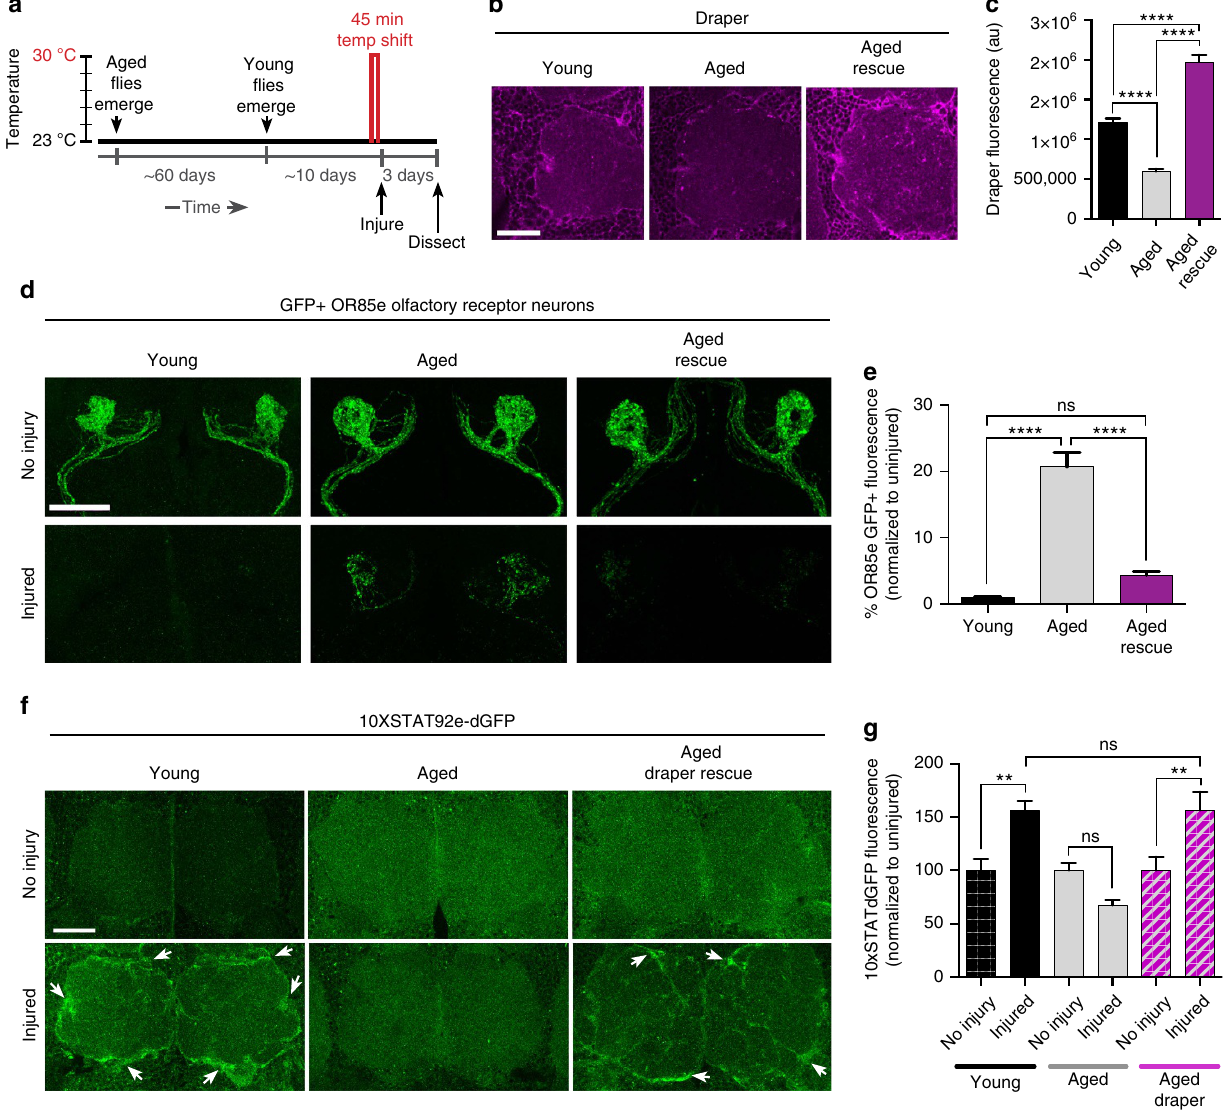
Figure 4 | Expression of Draper in aged glia rescues glial clearance of axonal debris. ( a ) Schematic of the Gal80 ts temperature-regulated paradigm to acutely induce expression of Draper-I in aged glia after injury. ( b ) Representative images of Draper (magenta) immunostained brains. ( c ) Quantification of Draper fluorescence in the cortex of Young, Aged and Aged Draper-I rescue brains; mean ± s.e.m. plotted; **** P o 0.0001, one-way analysis of variance (ANOVA) with Sidak post-hoc test; N Z 20. ( d ) Confocal projections of OR85e GFP þ axonal projections in uninjured flies versus 3 days after maxillary nerve axotomy. Expression of Draper-I in aged glia (Aged rescue) restored normal clearance of axonal debris. ( e ) Quantification of axonal clearance shown in d ; mean ± s.e.m. plotted, NS, not significant, **** P o 0.0001, one-way ANOVA with Sidak post-hoc test. N Z 14. ( f ) Representative images of antennal lobes showing expression of dGFP under the control STAT92E activity ( 10XSTAT92E-dGFP ) immunostaining (green) in Young, Aged and Aged Draper-I rescue animals. ( g ) Quantification of dGFP shown in f ; mean ± s.e.m. plotted, NS, not significant, ** P o 0.01, one-way ANOVA with Sidak post-hoc test; N Z 18. NS, not significant. Scale bars, 30 m m. Genotypes: b – e , Young ¼ w 1118 ;OR85e-mCD8::GFP, tubulin-Gal80 ts / þ ; repo-Gal4/ þ . Aged ¼ w 1118 ;OR85emCD8:: GFP, tubulin-Gal80ts/ þ ; repo-Gal4/ þ . Aged rescue ¼ w 1118 ;OR85e-mCD8::GFP, tubulin-Gal80ts/UAS-Draper-I; repo-Gal4/ þ . f , g , Young ¼ w 1118 ; 10xSTAT92e-dGFP, tubulin-Gal80ts/ þ ; repo-Gal4/ þ . Aged ¼ w 1118 ; 10xSTAT92e-dGFP, tubulin-Gal80ts/ þ ; repo-Gal4/ þ . Aged